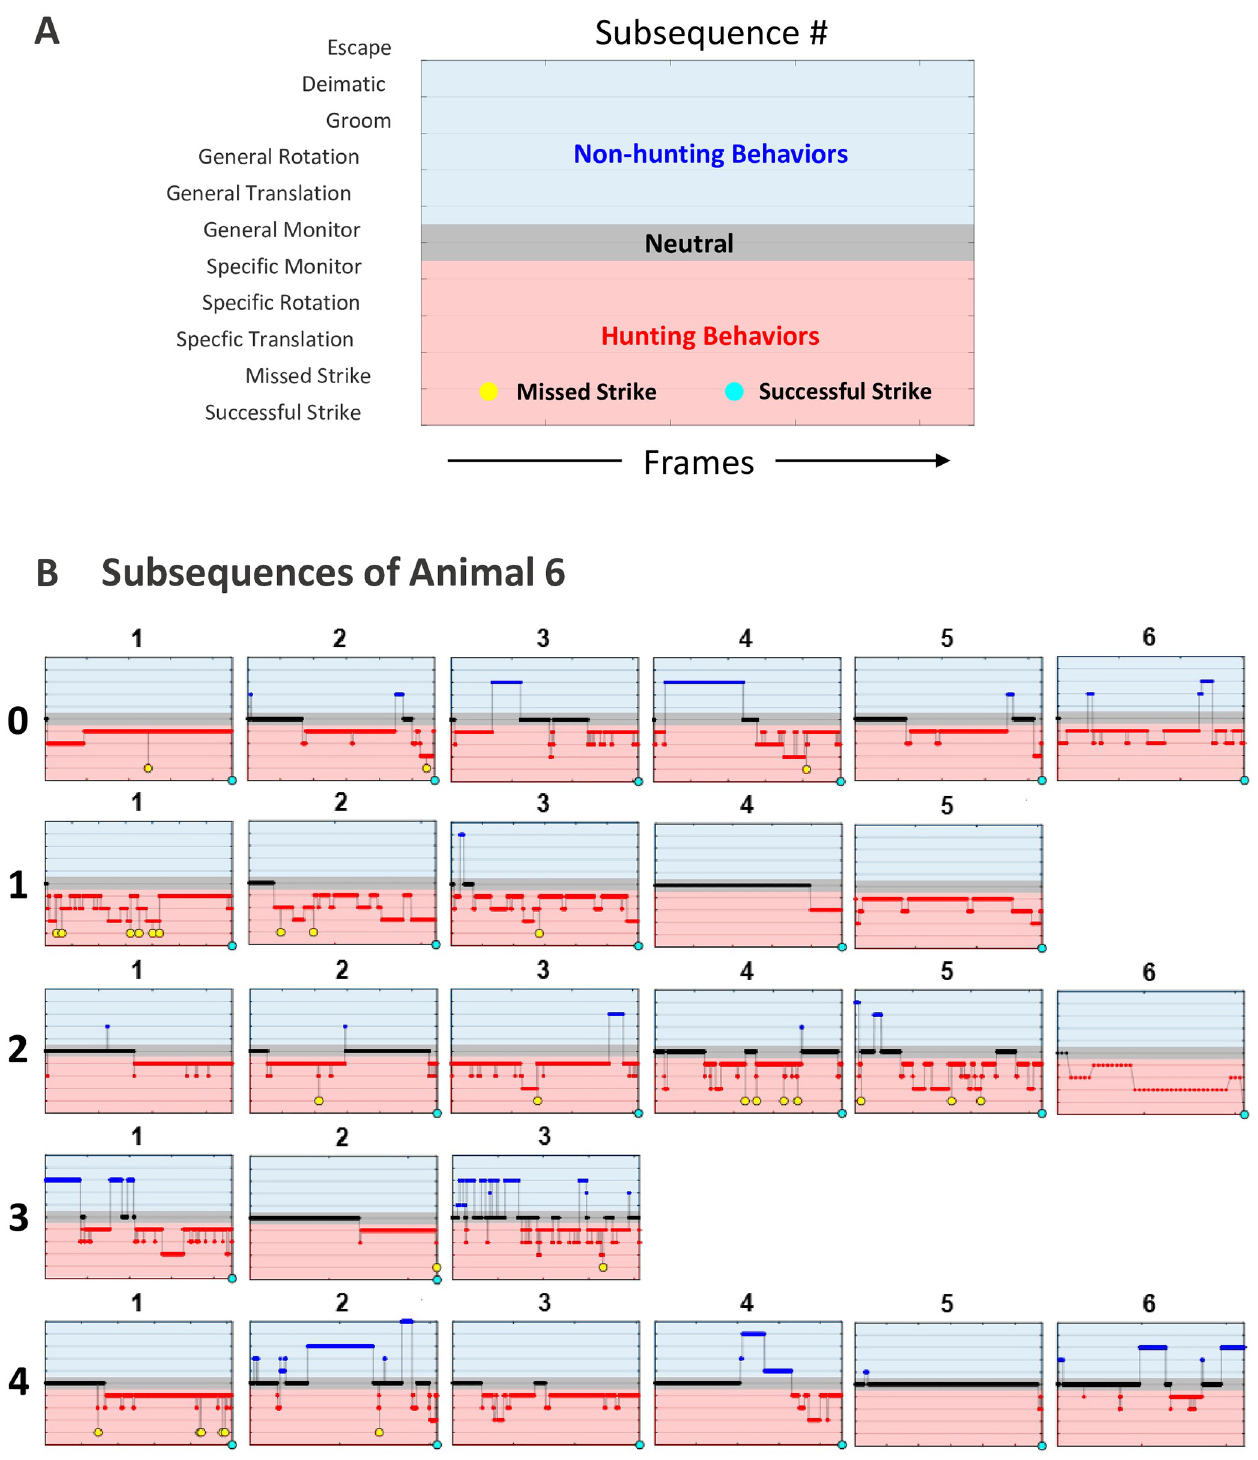
Fig 2. Example raw behavioral data across all feeding states (0-, 1-, 2-, 3- and 4-fed). (A) Color and symbol key for interpreting plots of part (B). The defined behaviors (y-axis) are plotted against frame number (x-axis). The colors red/black/blue are used to signify the different behavioral regimes. Red corresponds to the defined hunting behaviors: specific translation, specific rotation, and specific monitoring towards prey. Within the red hunting regime, strikes are denoted with circles; missed strikes are filled with yellow while successful strikes are cyan (which can only occur at the end of a subsequence as it will causes an arena reset). The grey region is the general monitoring where the praying mantis is motionless and not attentive to prey. Blue corresponds to